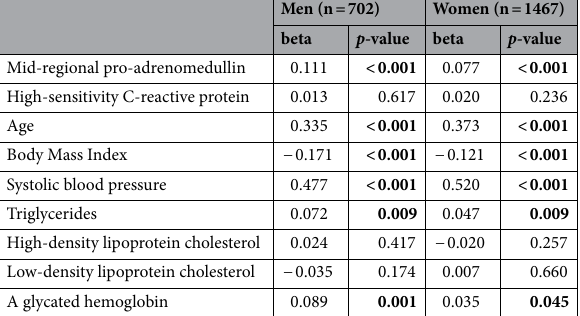
Table 4. Multivariate analysis of association with brachial-ankle pulse wave velocity. Adjusted for age, drinking and smoking status. Analysis were performed by multiple regression analysis. Bold style represents p <